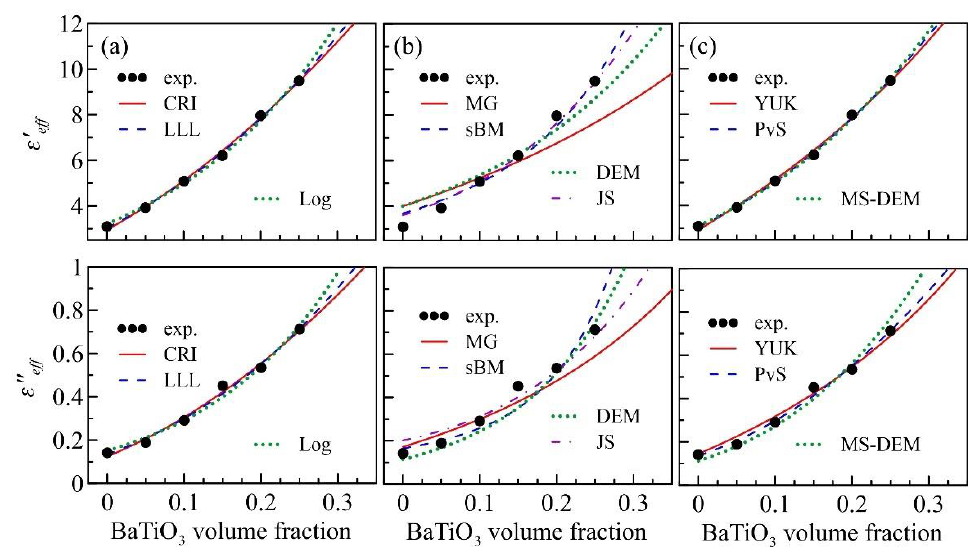
Figure 4. Comparison of the experimental results and the predictions from ( a ) CRI, LLL and Log; ( b ) MG, sBM, DEM and JS; and ( c ) YUK, PvS and MS-DEM. The top (bottom) panel shows eff  (  ) versus volume eff